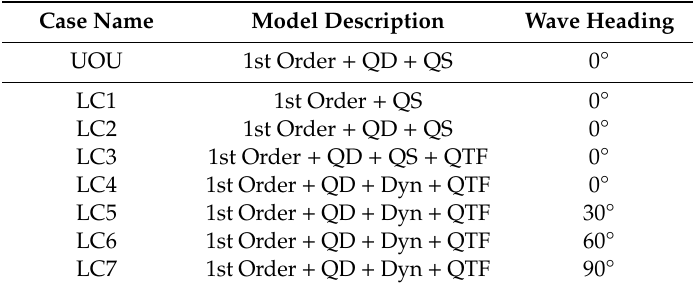
Table 3. The description of load